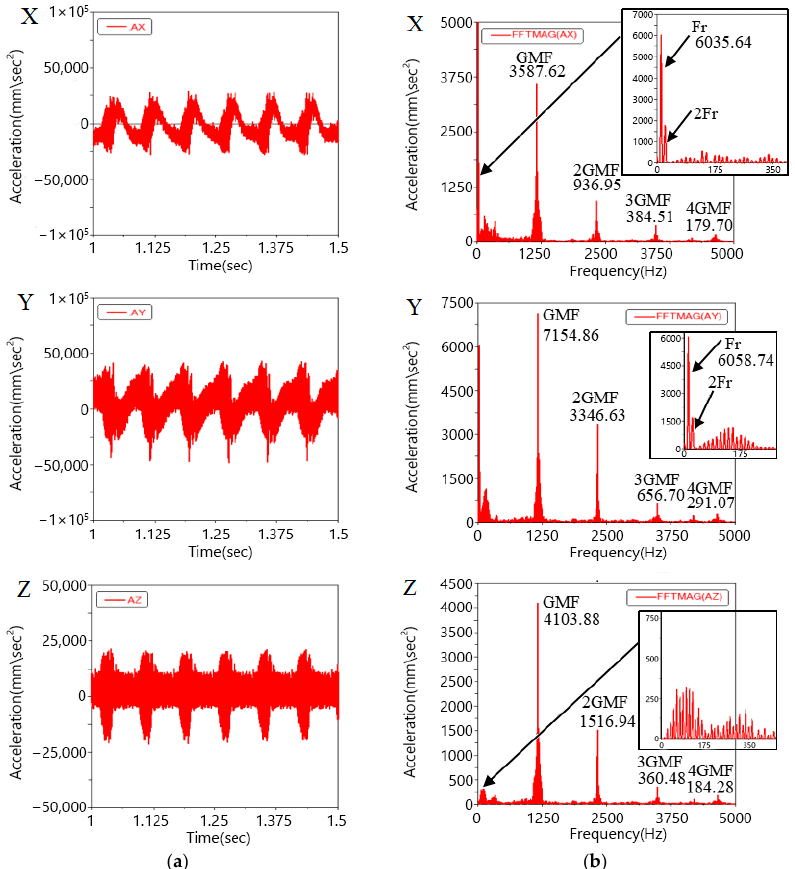
images of positions 1–4 of ( a ) (position 5 has the similar distribution).